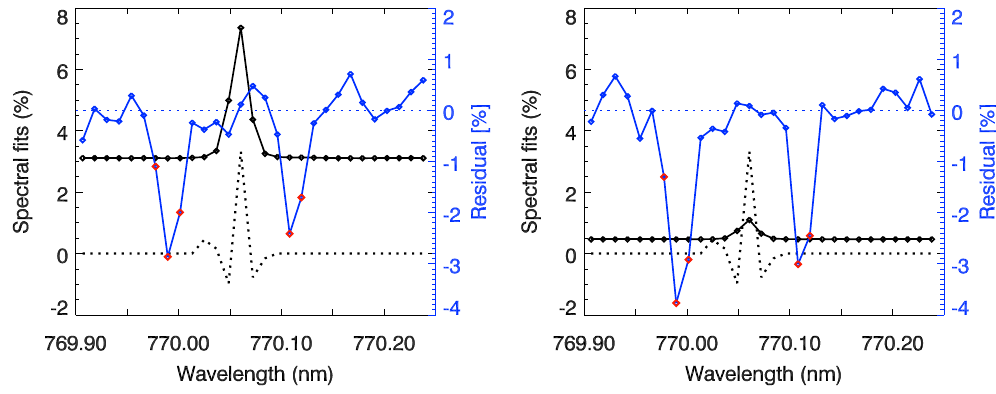
Fig. 6. Spectral structure as a percent of the continuum reflectance (left axis): dotted line is unexplained spectral structure (assumed due to undersampling and rotational-Raman scattering) and black solid line and diamonds represent the spectral fit of the fluorescence. The radiance residuals (observed minus computed) are shown by the blue solid line, where blue diamonds are for fitted wavelengths and red are for those not fitted. These are the same two pixels shown in Fig. 5 (Eastern US on left and Sahara on right). Results are for the P polarization.